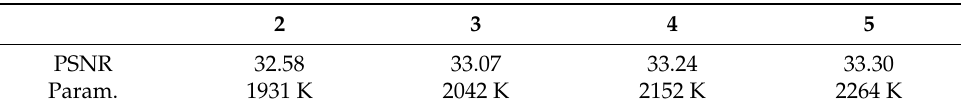
Table 5. Effects of different super-parameter of P . We report the best average PSNR(dB) on Set14 (×2) in 2.5 × 10 4